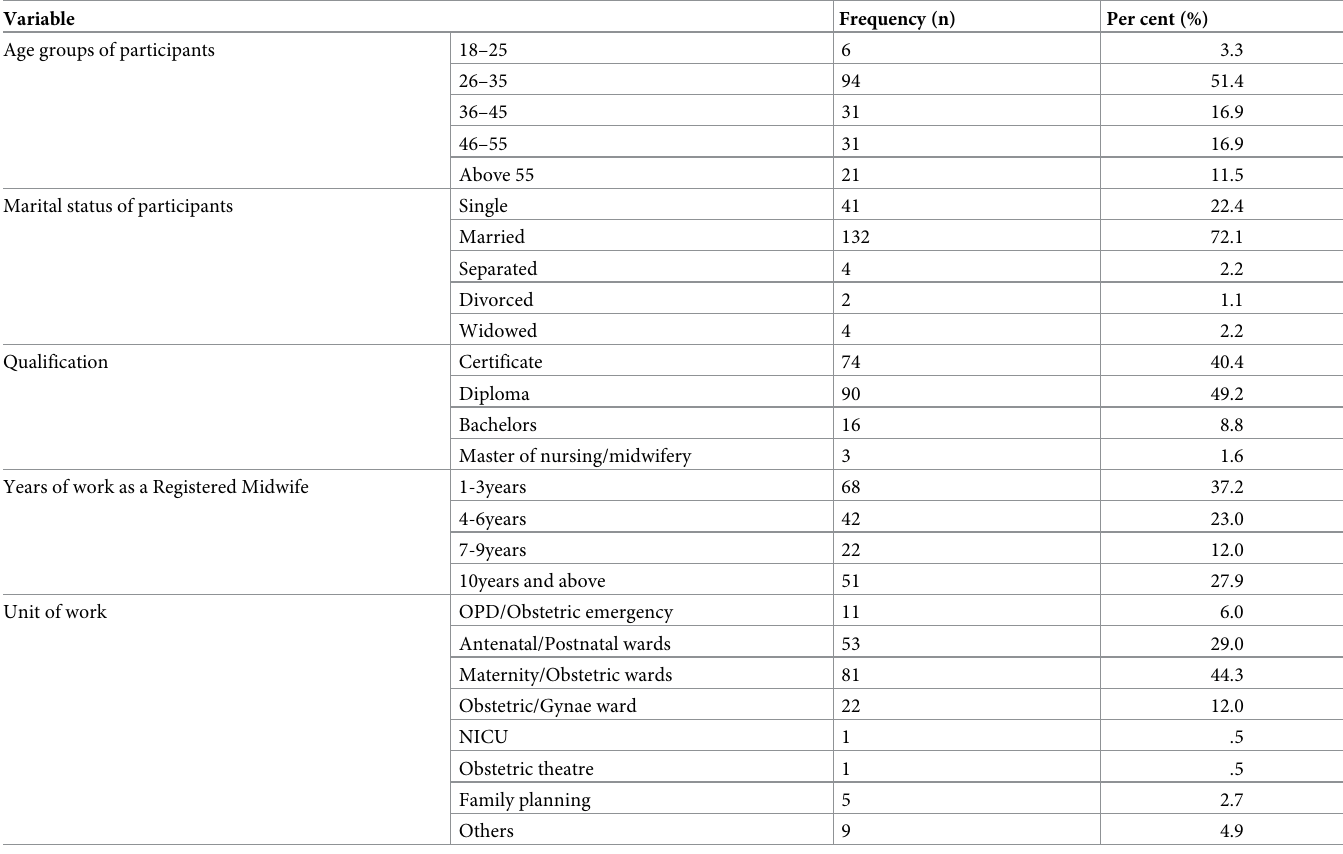
Table 1. Demographic characteristics of